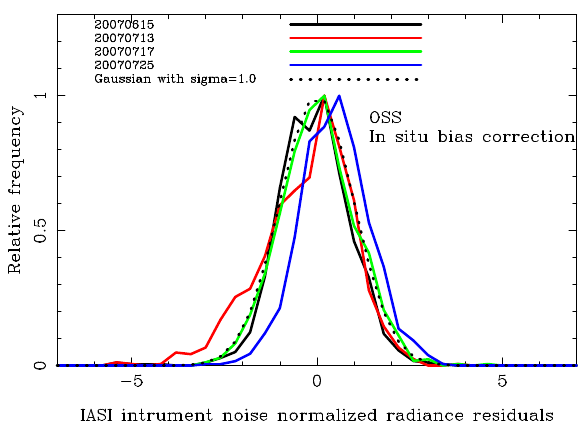
Fig. 13. Histogram of the residual radiances, IASI observed minus calculated with OSS RTM and the time interpolated profiles, for all clear days (4) in the spectral range, 1500cm − 1 ≤ ν ≤ 1570cm − 1 and 1615cm − 1 ≤ ν ≤ 1800cm − 1 . The interpolated profile has been derived from the CFH sonde launched 1h before IASI overpass and the “in situ” bias corrected RS92 sonde launched 5min before satel- lite overpass. The results for each one of the different observing days are shown independently in this figure. A one sigma Gaussian is shown as a dotted